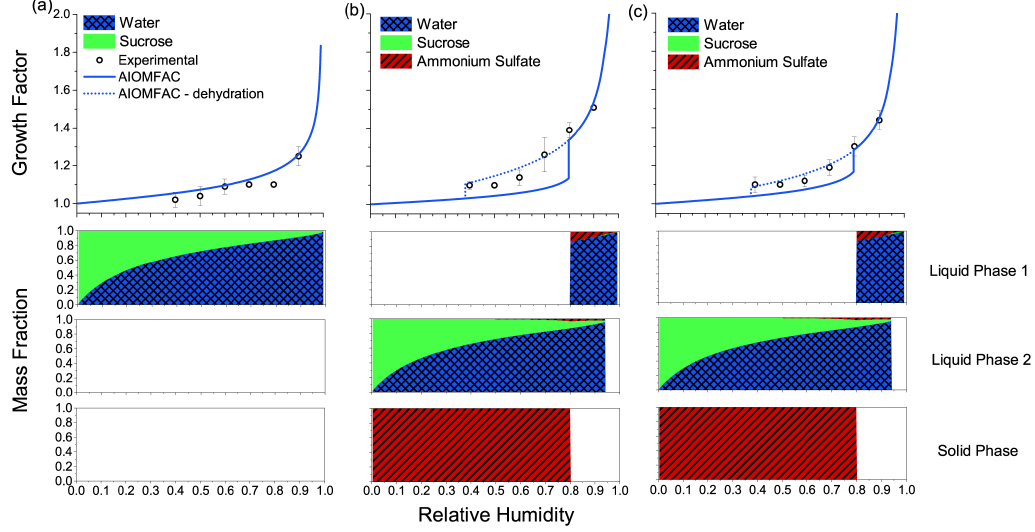
Figure 3. Top panels: Measured and AIOMFAC-predicted hygroscopic growth factors for (a) sucrose particles, (b) mixed sucrose– ammonium sulfate particles with an organic:inorganic ratio of 1:1, and (c) mixed sucrose–ammonium sulfate particles with an or- ganic:inorganic ratio of 2:1. The black circles indicate the average growth factor measured across 10 experiments, and error bars indicate the standard deviation of the measured growth factors. Solid lines indicate the hydration curve calculated with the AIOMFAC-based equilib- rium model, while dashed lines illustrate the dehydration branch in which a supersaturated solution is present with respect to the dissolved ammonium sulfate. The three panels below the hygroscopic growth curves indicate the AIOMFAC-predicted composition of each of three possible phases present in the particles during the hydration process (liquid phase 1, liquid phase 2, and a solid phase) as a function of relative humidity. Empty boxes indicate that either no second liquid phase or no solid phase is